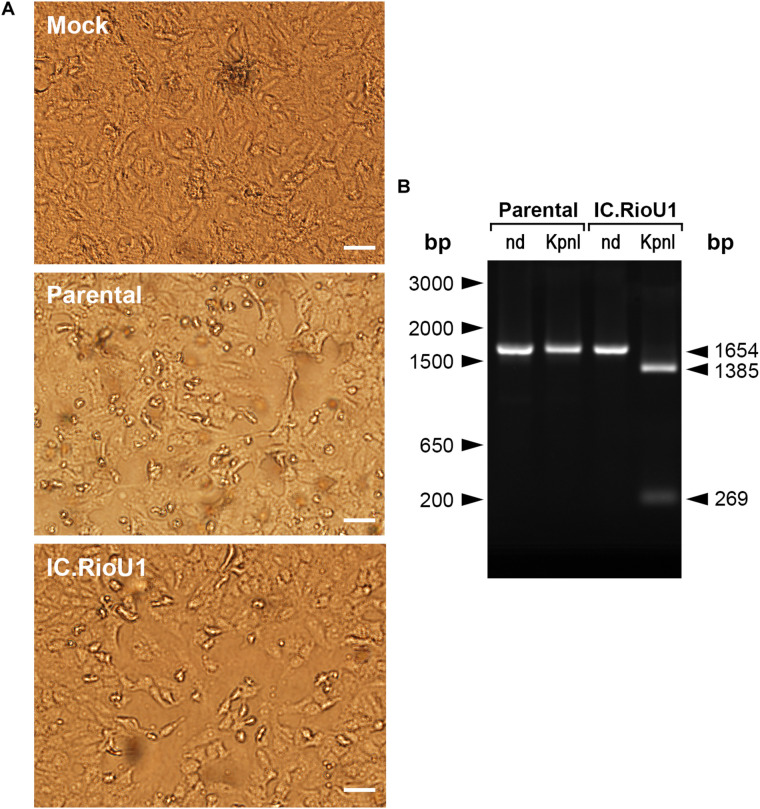
Recovery of synthetic ZIKV after Vero cell transfection. (A) Phase-contrast optical microscopy of culture flasks containing mock-infected Vero cells (Mock), positive control of Vero cells infected with ZIKV isolate Rio-U1 (Parental), or electroporated with synthetic ZIKV RNA (IC.RioU1). The white bars represent 100 μm. (B) Detection of ZIKV RNA in the extracellular medium by RT-PCR analysis. The electrophoretic profiles of amplicons obtained from (M) mock-infected cells, (P) Vero cells infected with ZIKV isolate Rio-U1, and (IC) synthetic ZIKV RNA. The amplicons were cleaved with KpnI. (nd) which means the control of the amplicons were not submitted to the KpnI digestion. The size marker migration is indicated on the right of the figure.